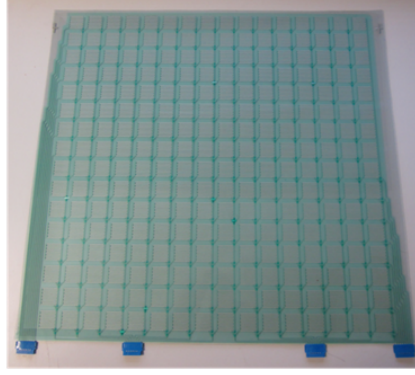
Figure 2. Picture of the 16 × 16 sensor array (45 cm 2 × 45 cm 2